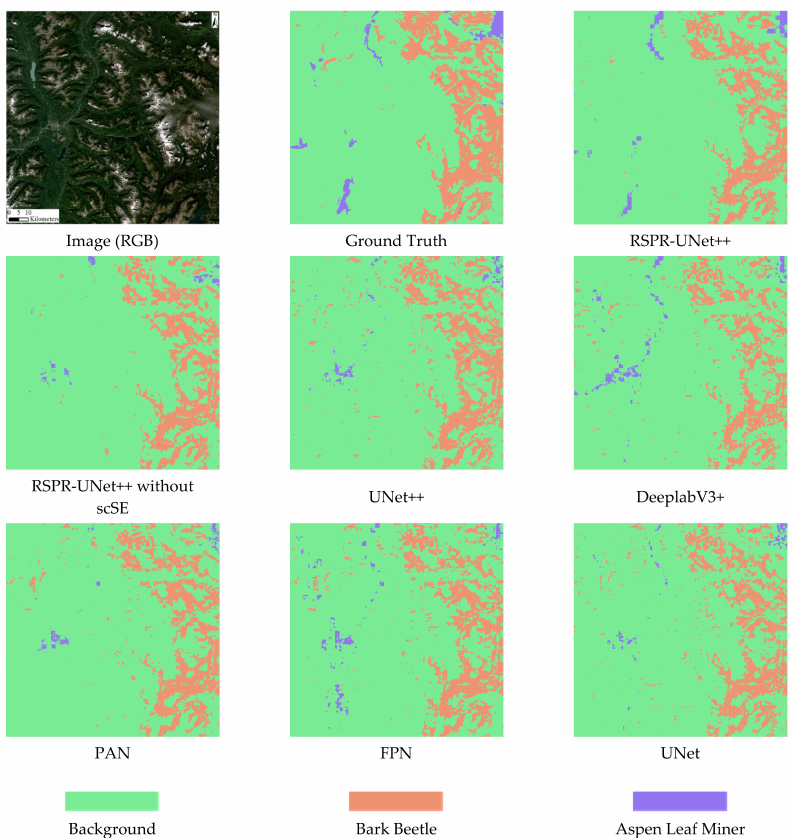
Figure 9. The segmentation effect of the whole Sentinel-2